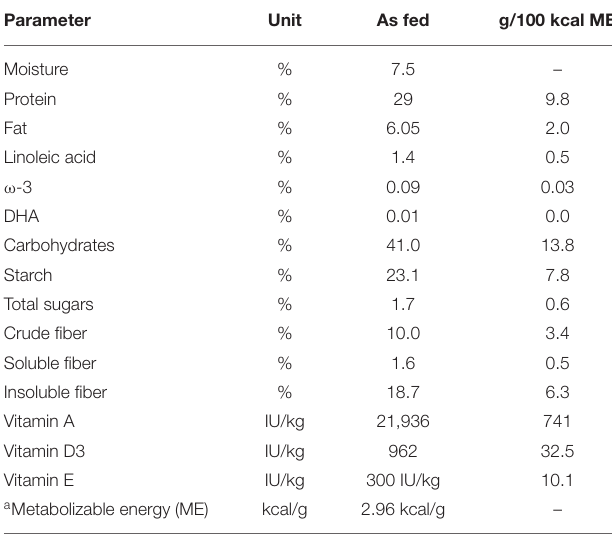
TABLE 1 | Chemical composition of the experimental diet administered to obese